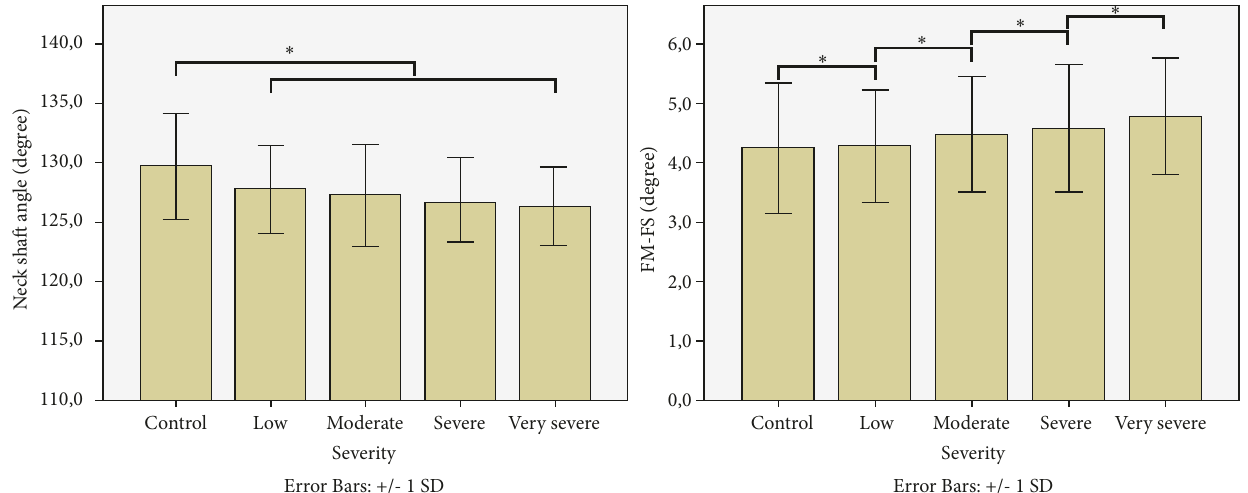
Figure 3: Mean values of the neck shaft angle (left) and FM-FS (right) based on the severity of the scoliosis. ∗ : significant difference based on independent sample t-test (p < 0.05).